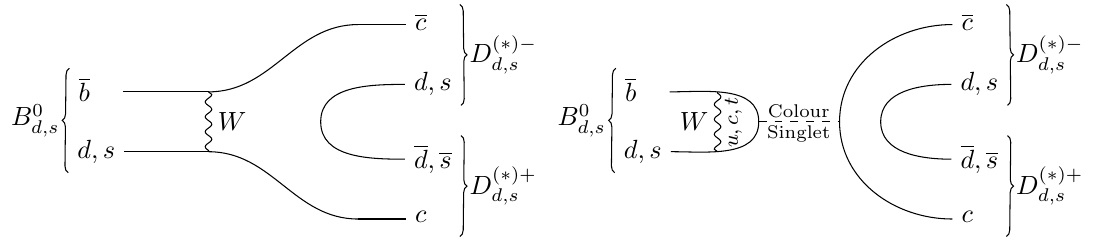
Figure 1 . (Left) Tree-level and (right) penguin diagrams contributing to B 0 → D ( ∗ ) ± → D ( ∗ ) ± B 0 D ( ∗ ) ∓ s decays. s ( s )